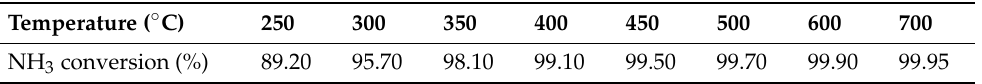
Table 8. Equilibrium ammonia conversion depends on temperature. Reprinted with permission [85].